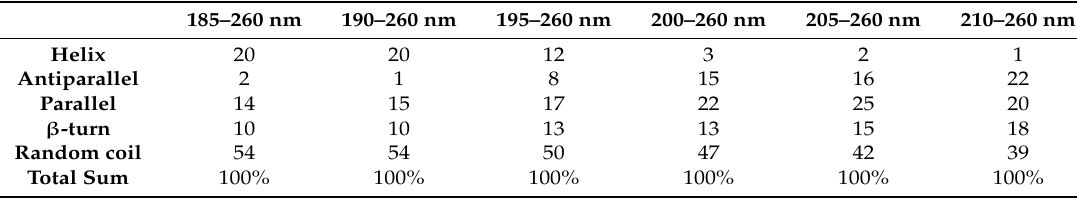
Table 1. Estimated data of a predicted secondary structure of TmPLB1 by CDNN